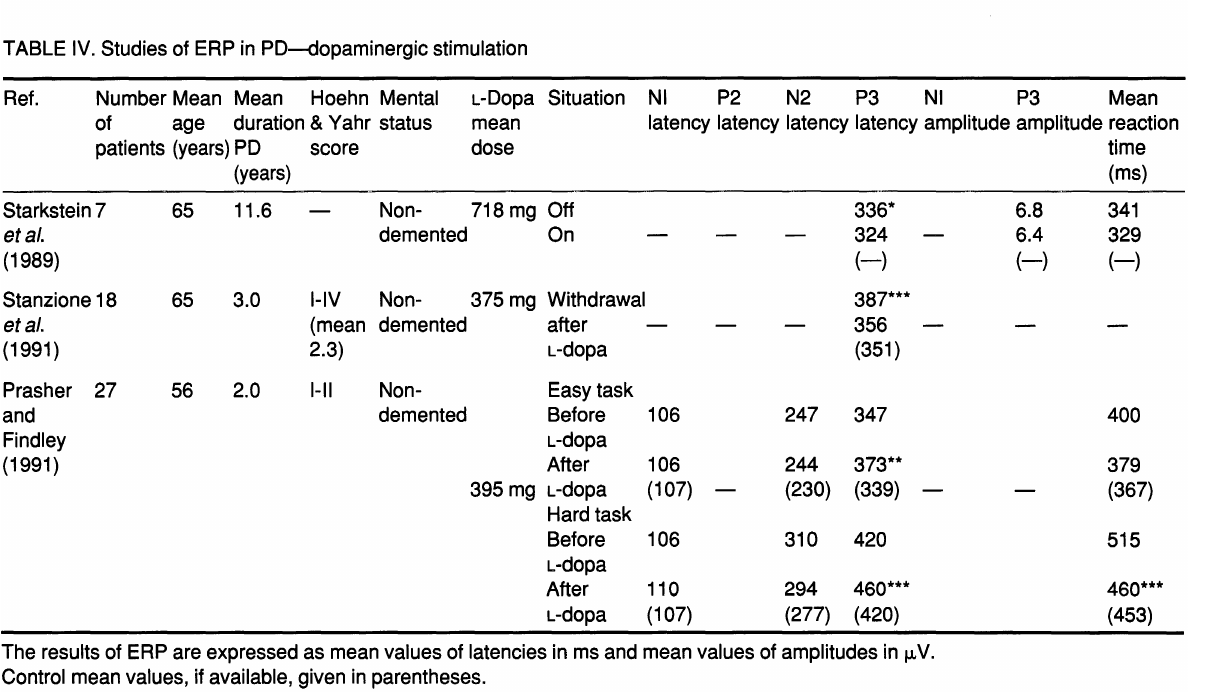
TABLE IV. Studies of ERP in PD-dopaminergic